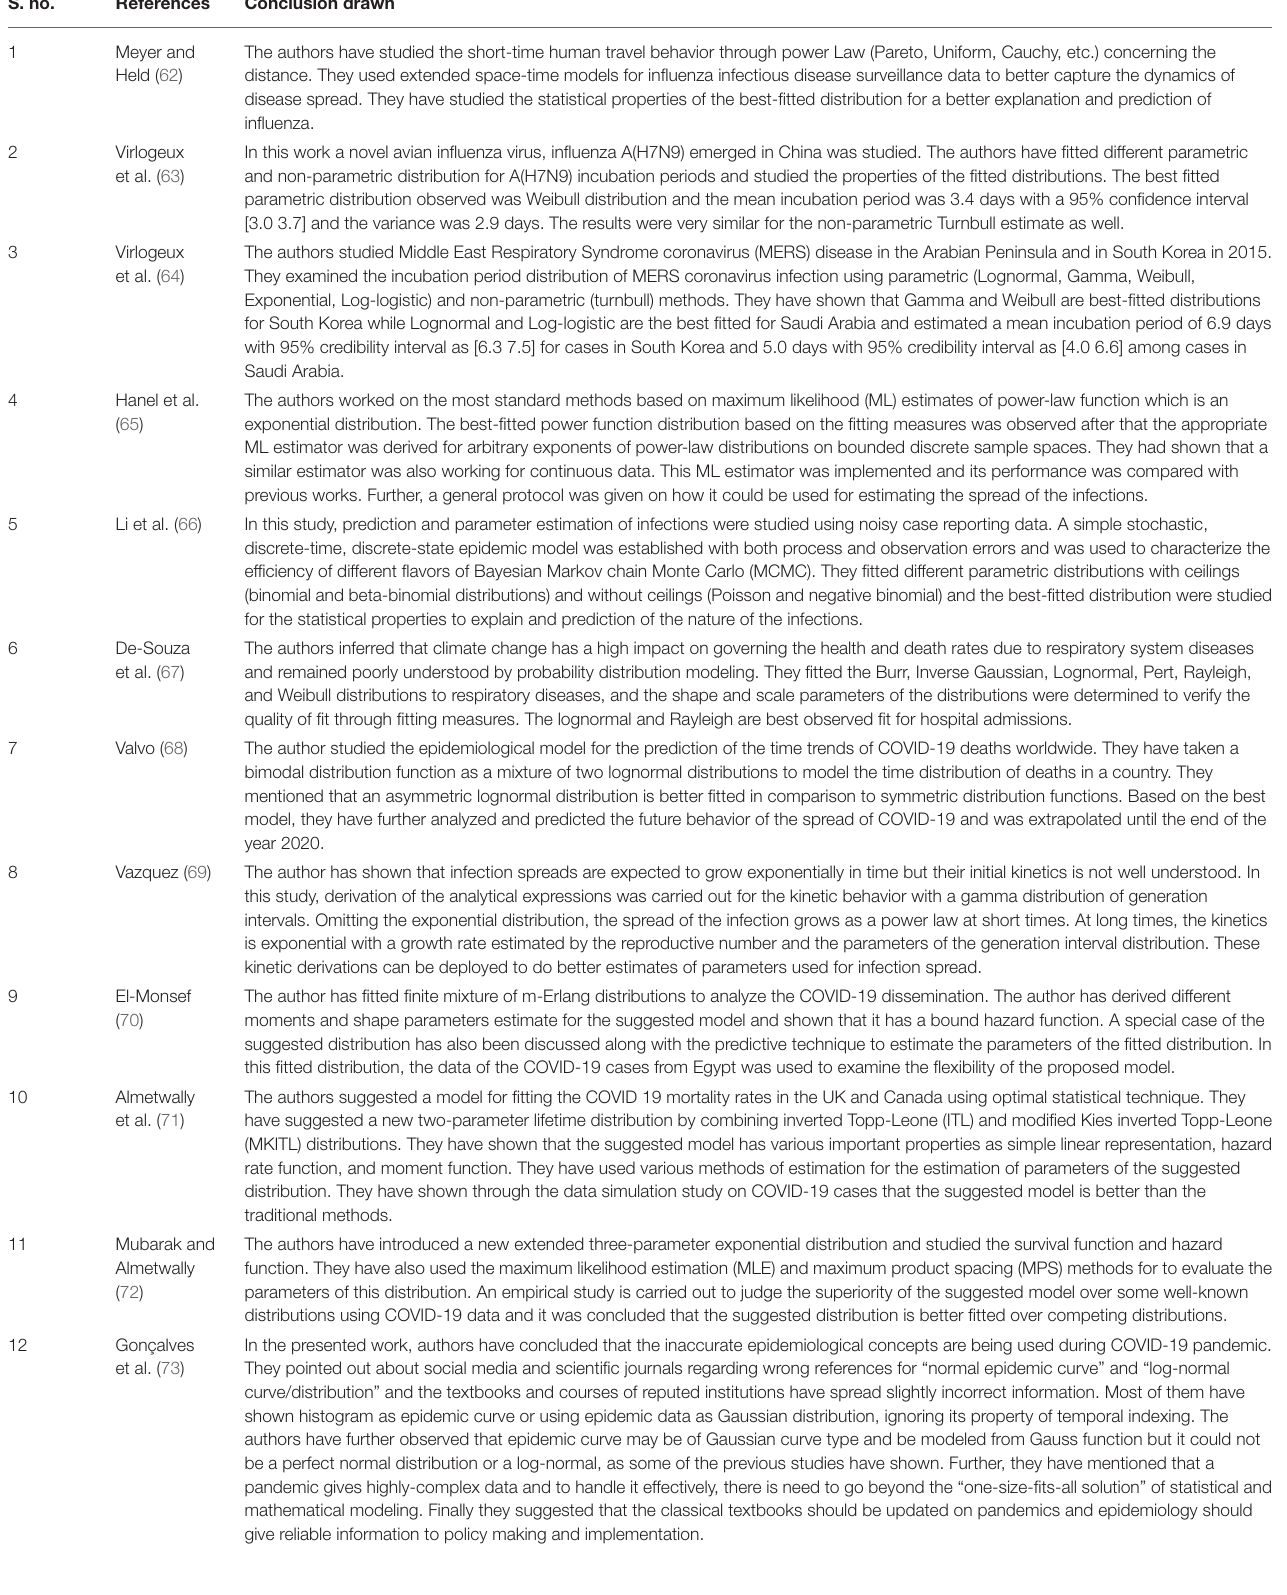
TABLE 1 | Fitting of different distributions for different infectious diseases. S.